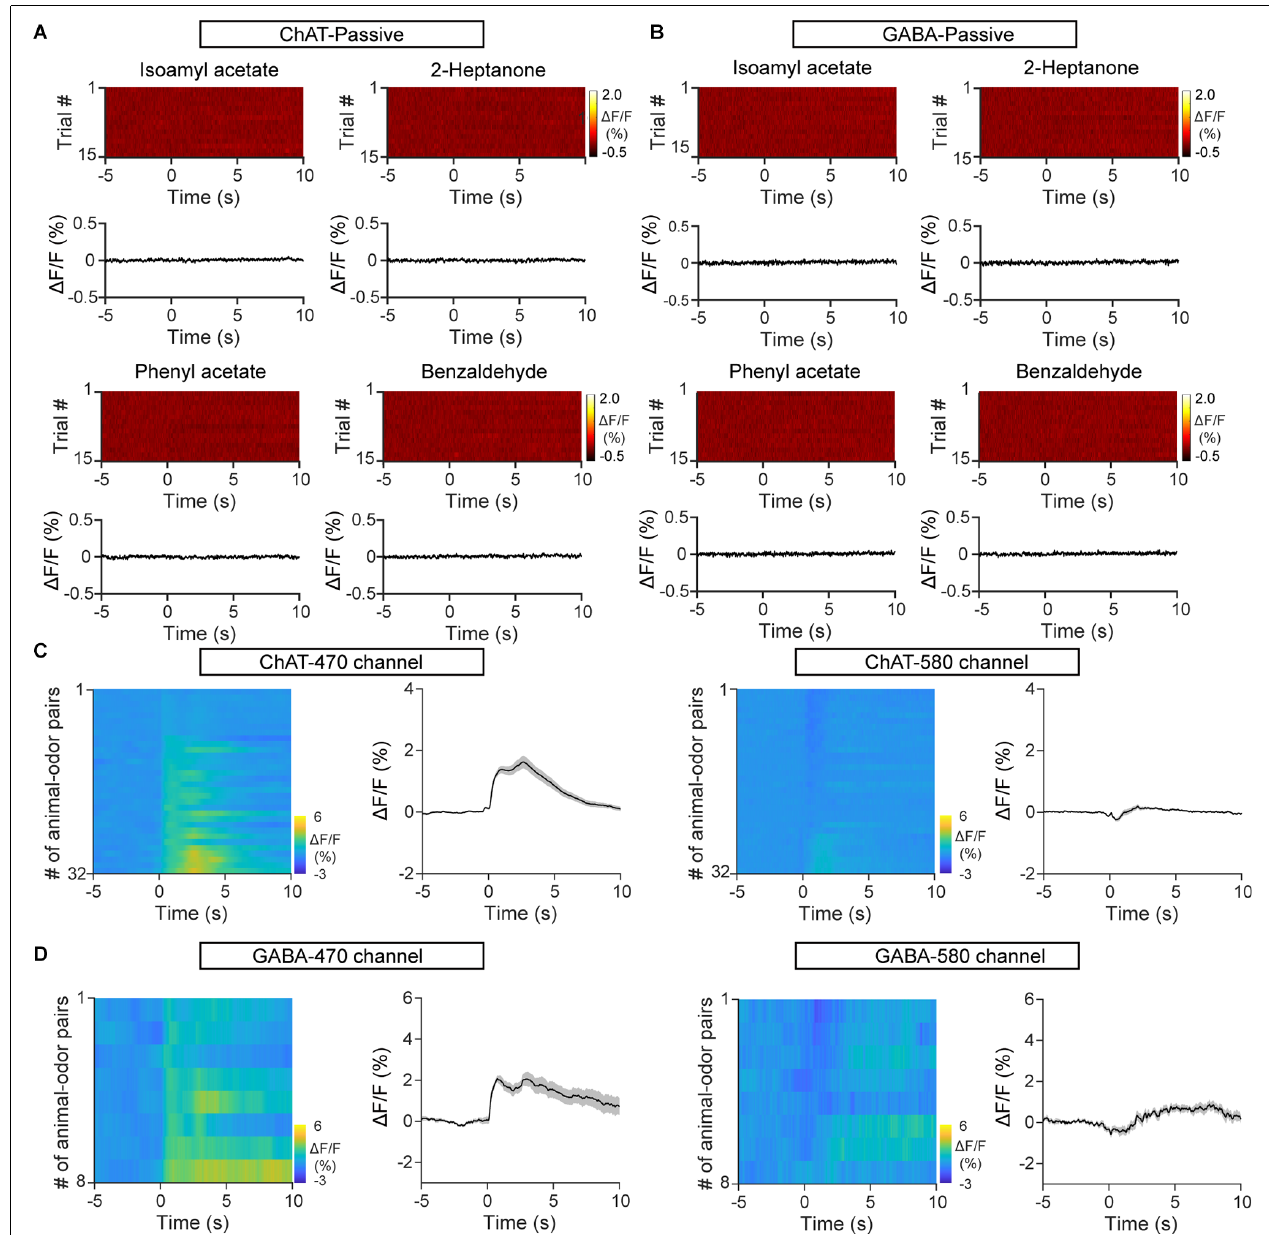
FIGURE 2 | Control mice expressing EGFP and the second fluorescent channel show no changes in fluorescence upon odor exposure. (A) Heat maps and trial-averaged traces of ∆ F/F from a representative C57BL/6J mouse injected with AAV-ChAT-Cre and AAV-DIO-EGFP. (B) Heat maps and trial-averaged traces of ∆ F/F from a representative VGAT-Cre mouse injected with AAV-DIO-EGFP. (C) Heat maps and trial-averaged traces of ∆ F/F recorded from C57BL/6J mice injected with AAV-ChAT-Cre and AAV-DIO-axon-GCaMP6s using the targeted recording channel (470 nm) and a second fluorescent channel (580 nm). n = 32 animal–odor pairs from four mice. (D) Heat maps and trial-averaged traces of ∆ F/F recorded from a VGAT-Cre mouse injected with AAV-DIO-axon-GCaMP6s using the targeted recording channel and the second fluorescent channel. n = 8 animal–odor pairs from one mouse.